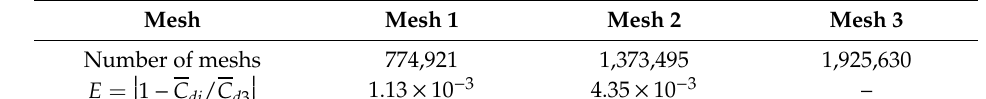
Table 4. Mesh independency study.